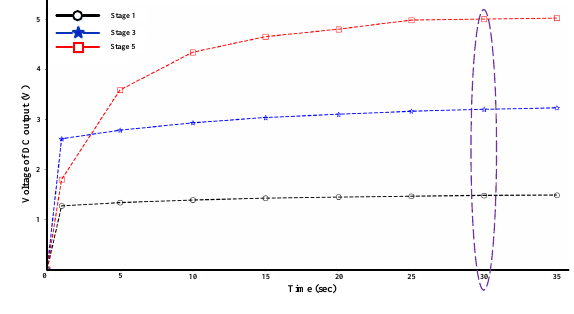
Figure 8. The DC output of different stages The stage numbers of the VM based on our desired output value and settling time. The settling time is the time to approach the desired value and get stable. Our simulation employs three di ff erent cases of the VM